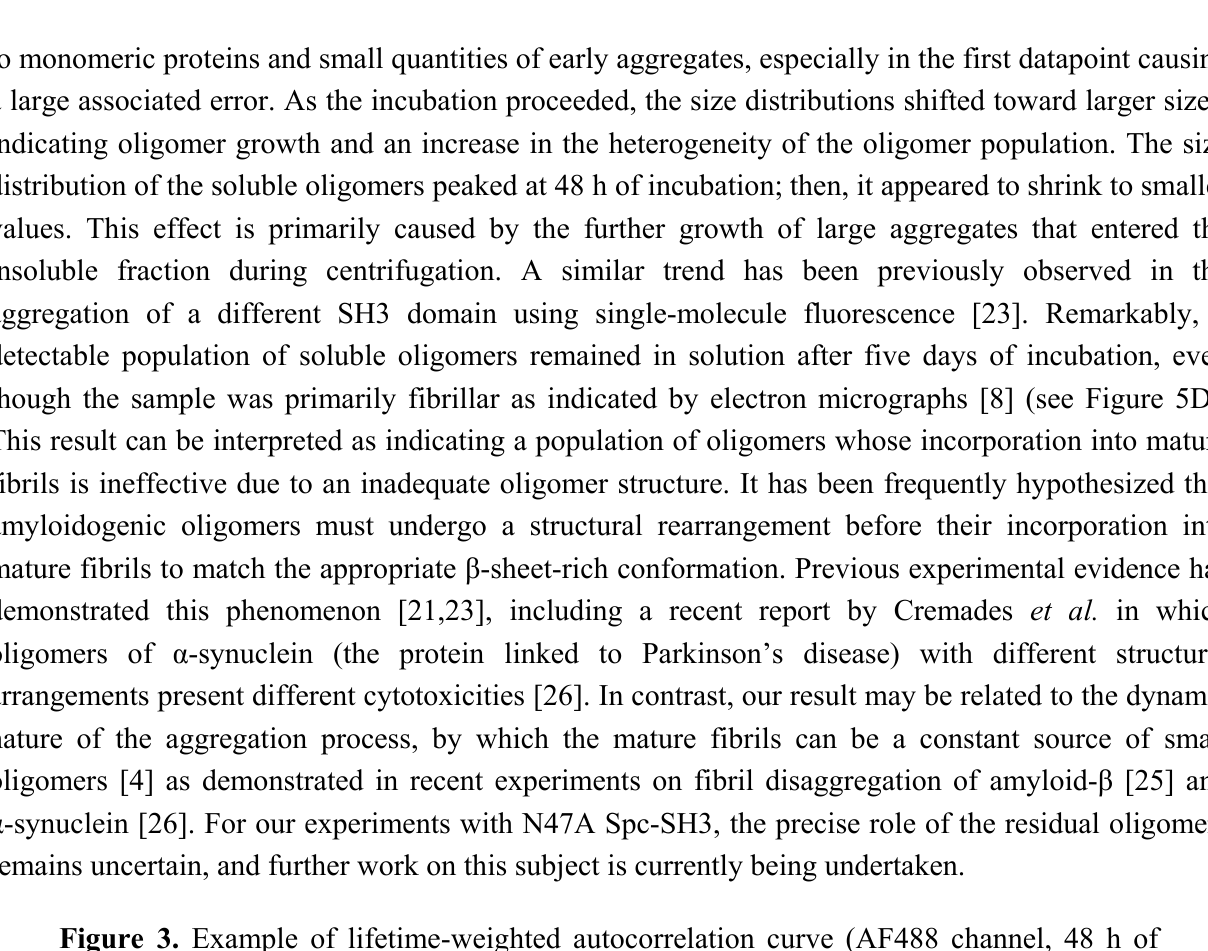
Figure 3. Example of lifetime-weighted autocorrelation curve (AF488 channel, 48 h of incubation time) fitted using Equation 7, the convolution of a log-normal distribution of sizes with the general autocorrelation function. The residuals plot (below) indicates the accuracy of the